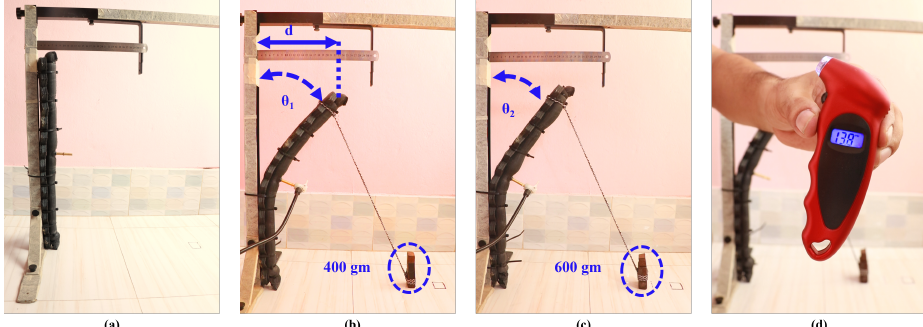
Figure 9. Experimented posture corrector, ( a ) spinal state at normal standing, ( b ) skeleton pulling with 4N force, ( c ) skeleton pulling with 6N force, and ( d ) pressure recorded at 6N force.